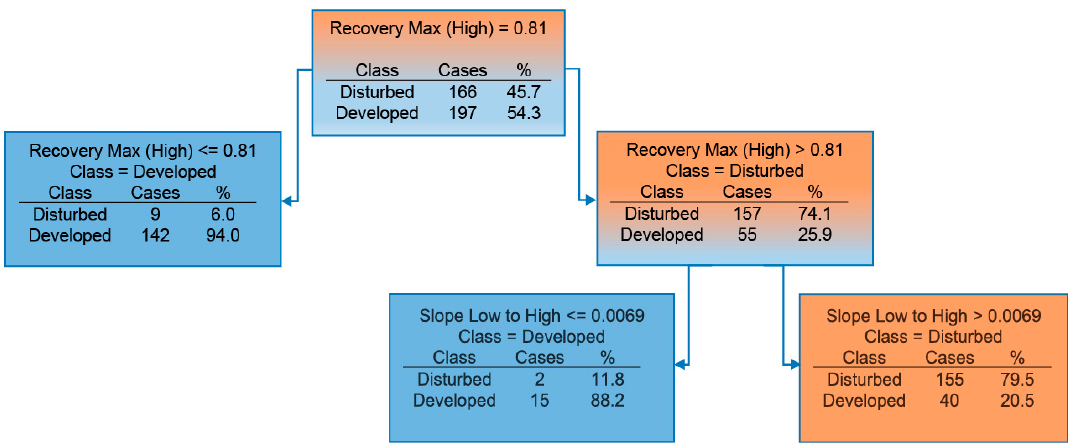
Figure 6. Resulting CART ® Tree from Salford Predictive Modeler v6.6. Cases in boxes shaded blue were classified as Development Disturbed while cases in the box shaded orange were classified as Non-Development Disturbed .